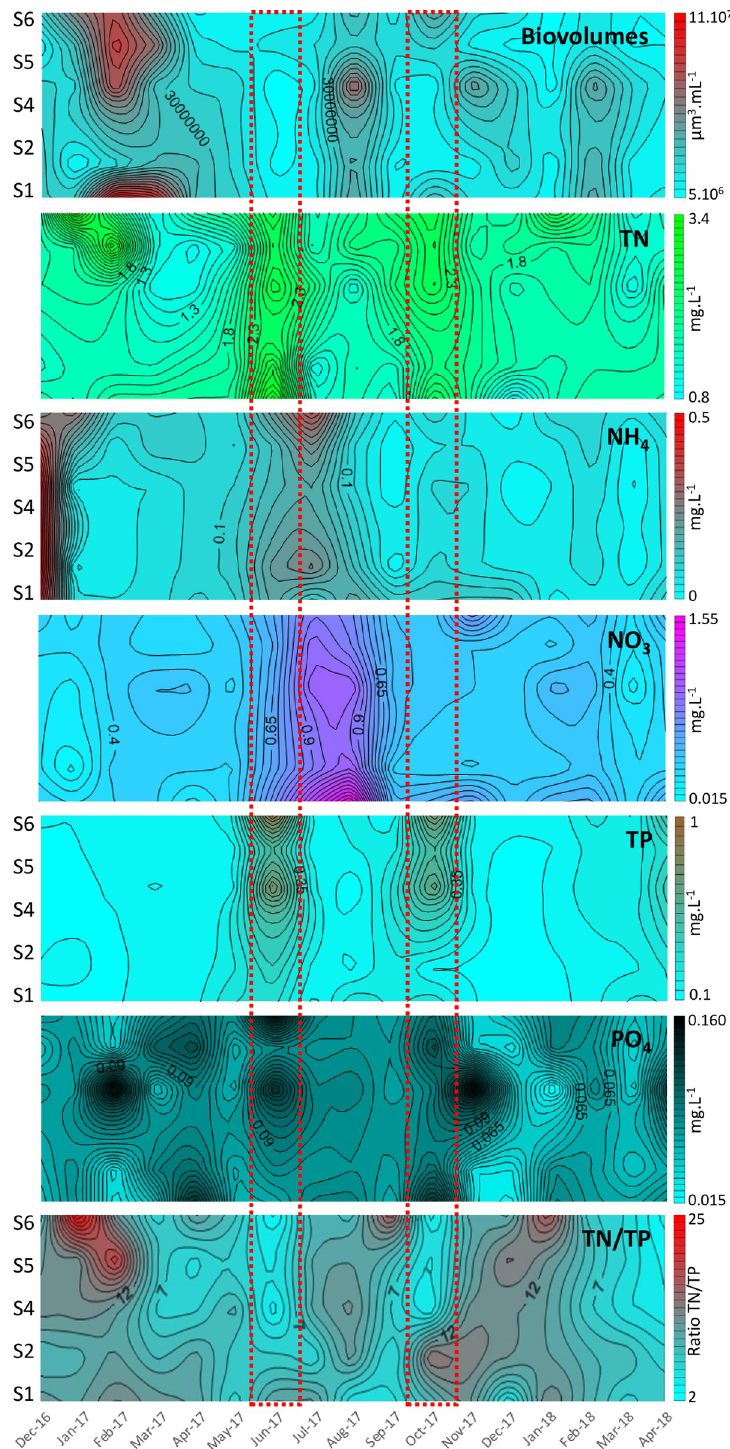
Fig 2. Spatiotemporal variations in the total biovolumes of the phytoplankton community and in the nutrient concentrations obtained during the monitoring of Lagoon Aghien. Only the sampling points located on the transect (S1, S2, S4, S5, and S6) are displayed in this figure. S1, S2, S4, S5, and S6 indicate the sampling stations; Biovolumes represents the phytoplankton biovolumes; TN represents total nitrogen; TP indicates total phosphorus; and N/P represents the TN/TP ratio. The red dotted rectangles correspond to the two rainfall peaks.